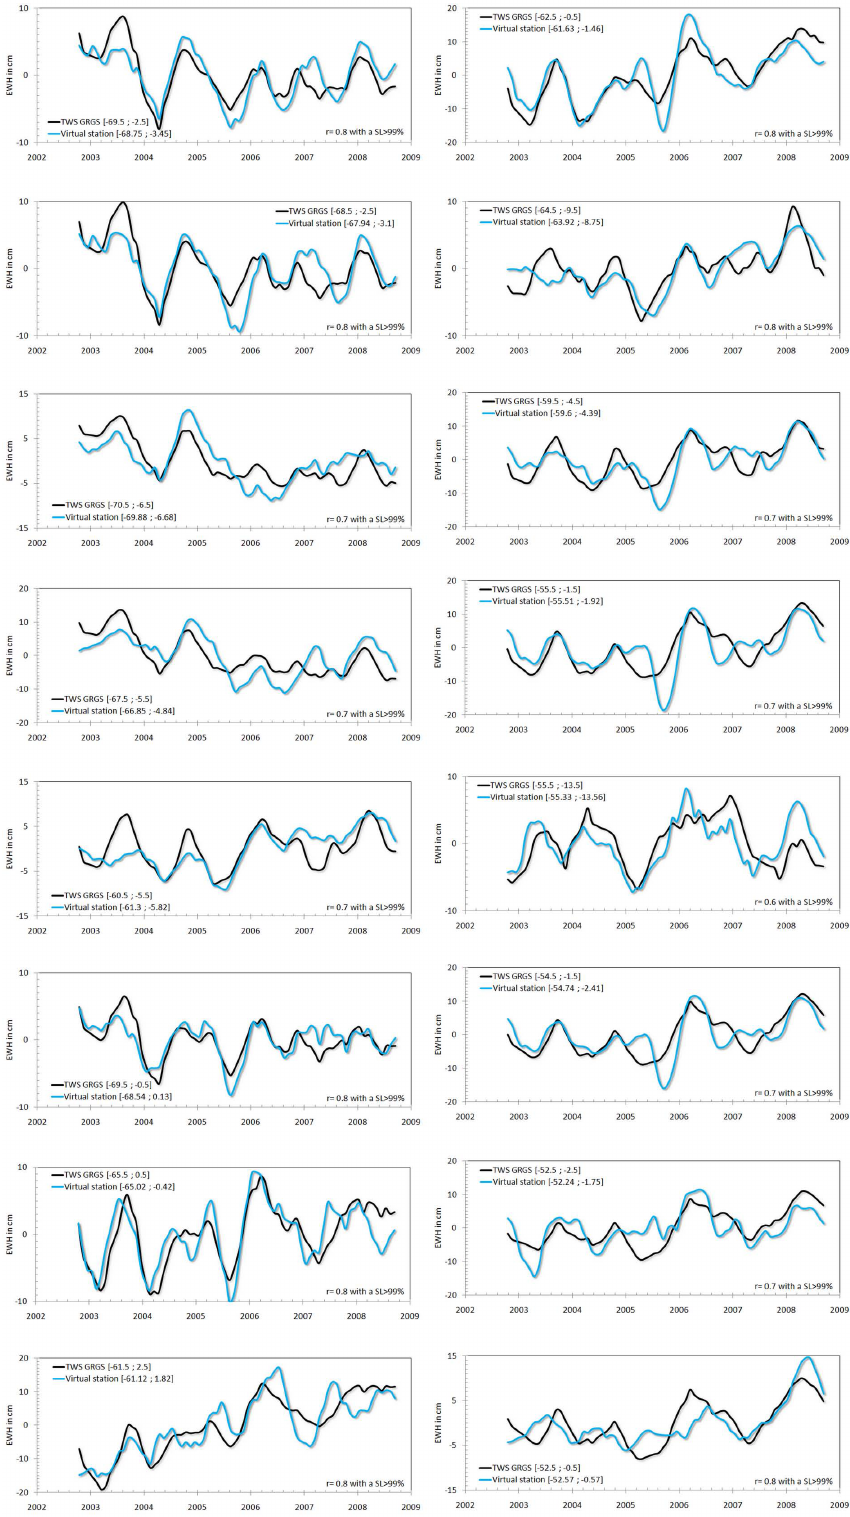
Fig. 3. Scaled EWH for in situ station. The figure shows the scaling result for some in situ stations (see red dots on Fig. 1 for locations). The TWS from GRACE over 2003–2008 period is plotted in black lines and the in situ river levels scaled in EWH over the same period are in blue lines. r is the correlation coefficient and SL its significance